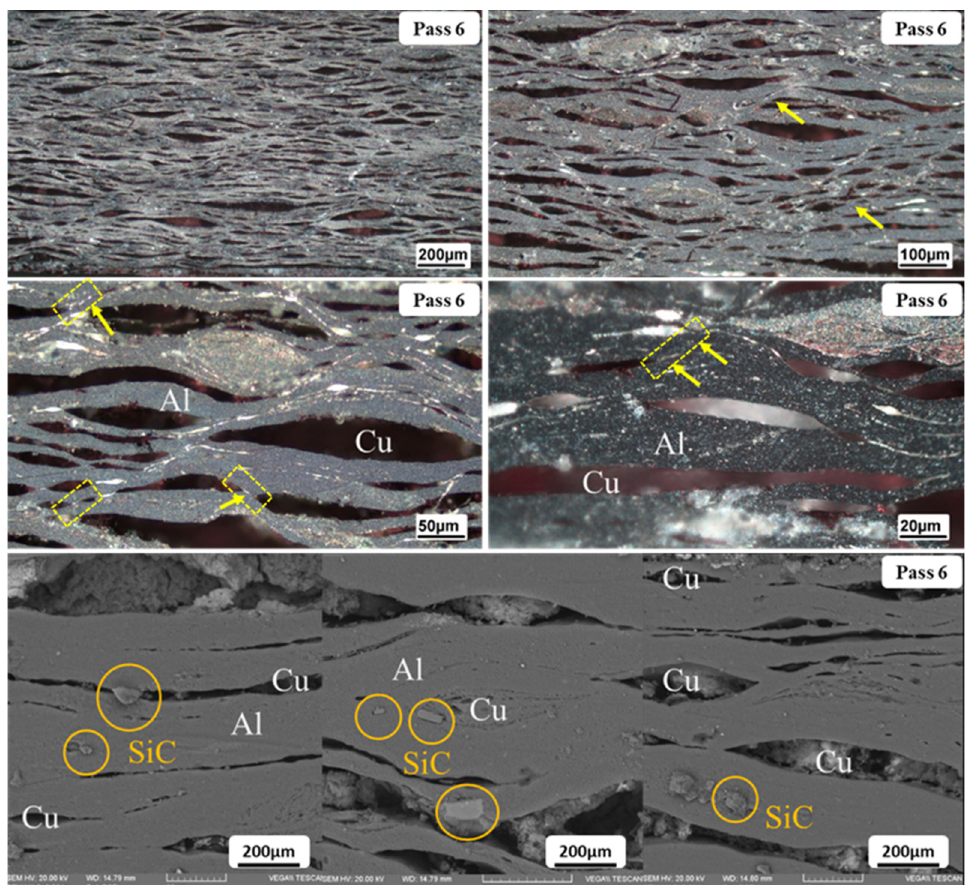
Figure 7. SEM images taken from different regions of the sixth pass of ARBed Al/Cu/3wt%SiC com- posite.